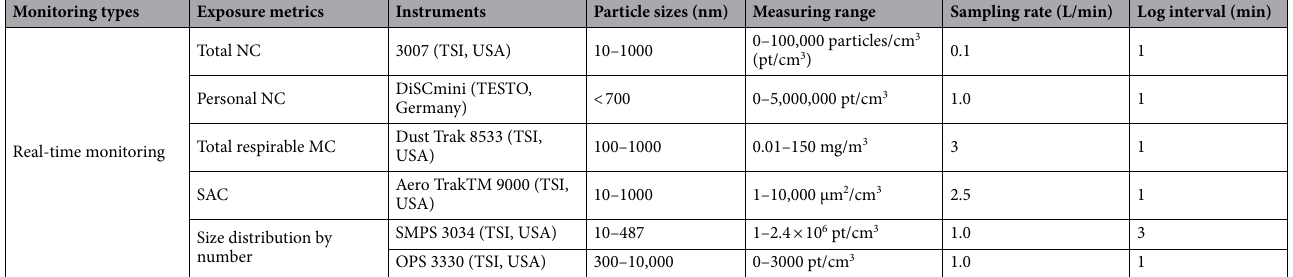
Table 1. Monitoring system for measuring the particles from